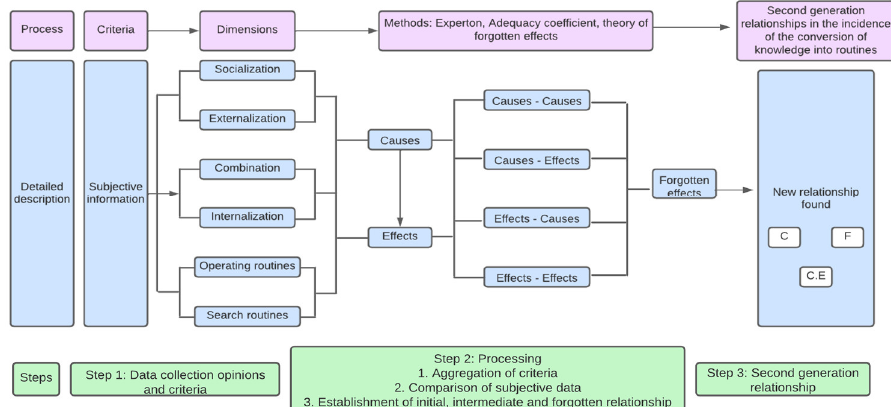
Figure 1. A second-generation relationship model in the incidence of the conversion of knowledge into routines. Source: Own elaboration based on the studies of Blanco-Mesa, Leon-Castro, and Castro-Amado [41].